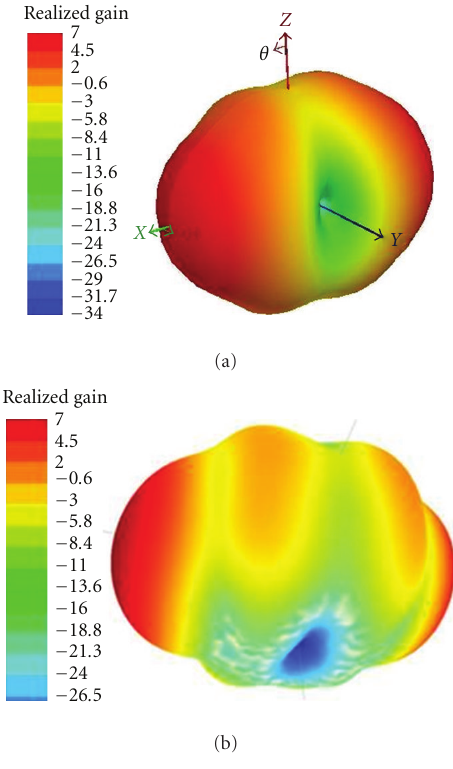
Figure 19: Simulated (a) and measured (b) 3D radiation pattern of the dual-beam printed dipole antenna.